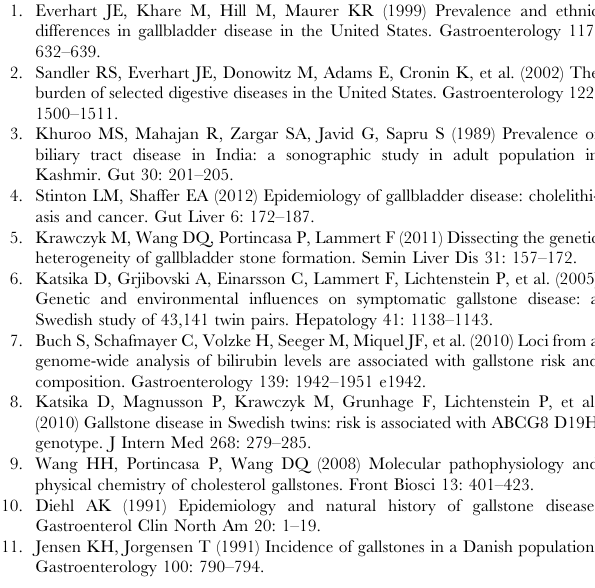
Table S1 The genes and SNPs investigated. Table S2 Haplotypes association of ESR1 gene (age and gender adjusted). Table S3 Haplotypes analysis of ESR2 gene (age and gender adjusted). Table S4 Haplotypes analysis of SLCO1B1 gene (age and gender adjusted). Table S5 Odds Ratios and 95% CI for Gallstones in Relation to Polymorphisms of Hormonal Pathway after Subdividing on the Basis of